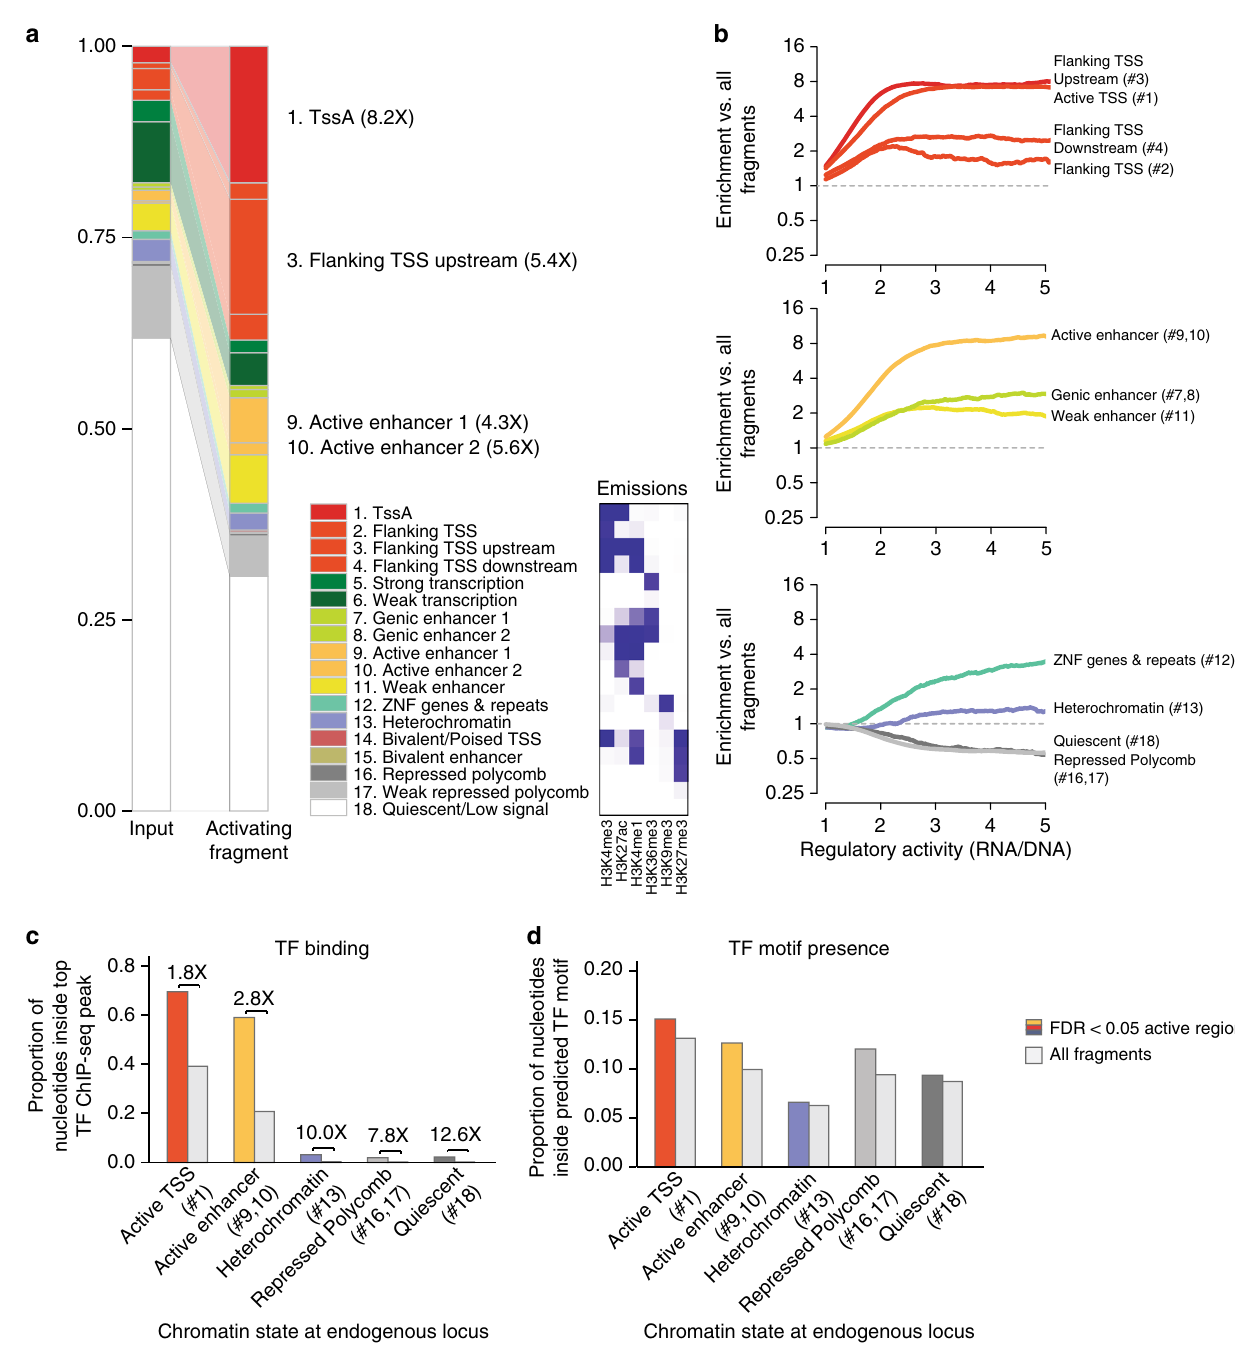
Fig. 3 Active HiDRA fragments are enriched in endogenously active regulatory regions. a Overlap of active HiDRA fragments with different endogenous chromatin states. Heights correspond to proportion of nucleotides within active HiDRA fragments in each chromatin state. Inset: histone modi fi cation enrichments in each of 18 ChromHMM chromatin states b HiDRA fragment regulatory activity (fold-change increase in RNA levels) across different chromatin states. Numbers correspond to chromatin state numbers in 18-state ChromHMM model. c , d Endogenously inactive genomic regions have low levels of TF binding ( c ) but comparable TF motif composition ( d ) to predicted active regions. Colored bars, regions from each chromatin state overlapping active HiDRA regions. Gray bars, regions from each chromatin state overlapping all fragments